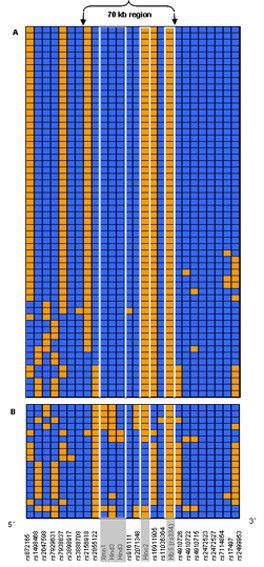
Jamaican βS haplotypes. Haplotypes designated as 'Benin' type are shown in part A; non-Benin type haplotypes are shown in part B. RFLP markers used to distinguish individual βS haplotypes have shaded marker labels and are outlined by the white border. Haplotypes are arrayed along the Y-axis with SNPs on the X-axis. At each SNP position, the major allele of each SNP is represented in blue and the minor allele in orange. For reference, the 70 kb region of the HBB cluster is indicated at the top of the figure.